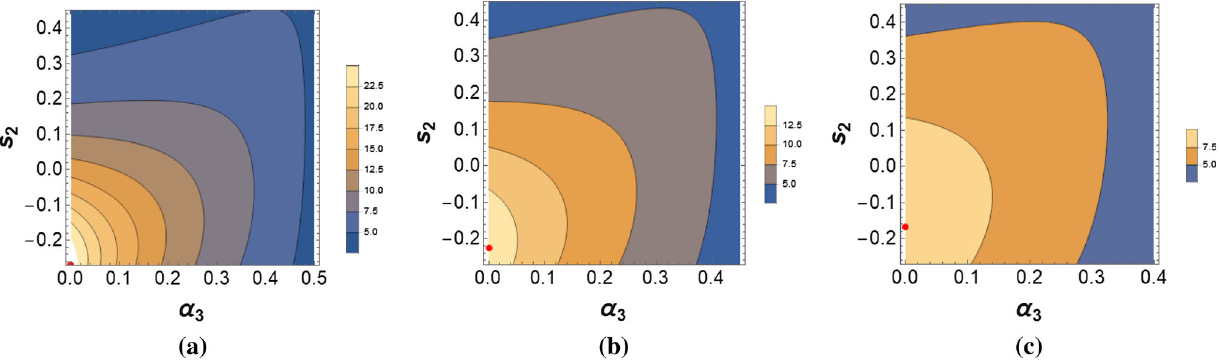
b = 0 . 1, η max = S max ≈ 14 . 4513with s 2 = − 0 . 2253; c when b = 0 . 2, η = S ≈ 9 . 7977 with s = − 0 . max max 2